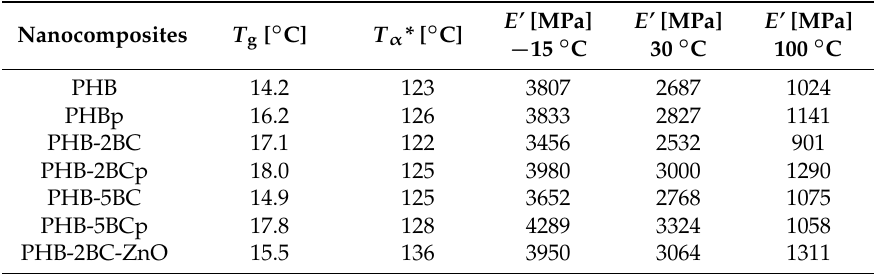
Table 3. DMA results: glass transition of PHB ( T g ), T α * transition (crystal ‒ crystal slip) and storage modulus ( E´ ) values at different temperatures.